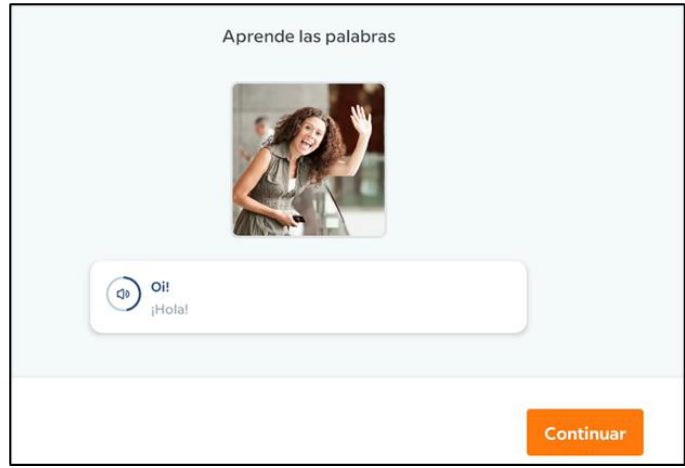
Figure 4. Vocabulary learning activity Lesson 1. Table 2. Categories of sub-activities.